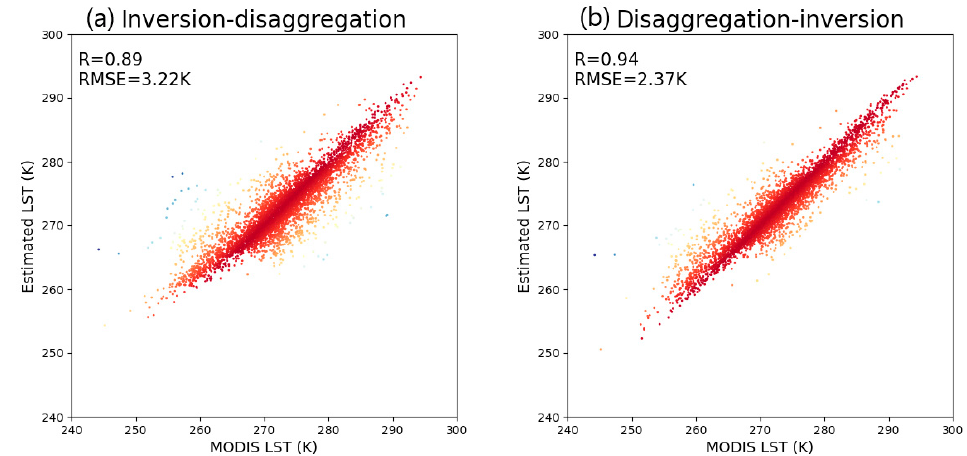
Figure 5. The estimated LST compared to MODIS LST. ( a ) inversion-disaggregation. ( b ) disaggregation-inversion. The darker color indicates a stronger correlation between two variables.